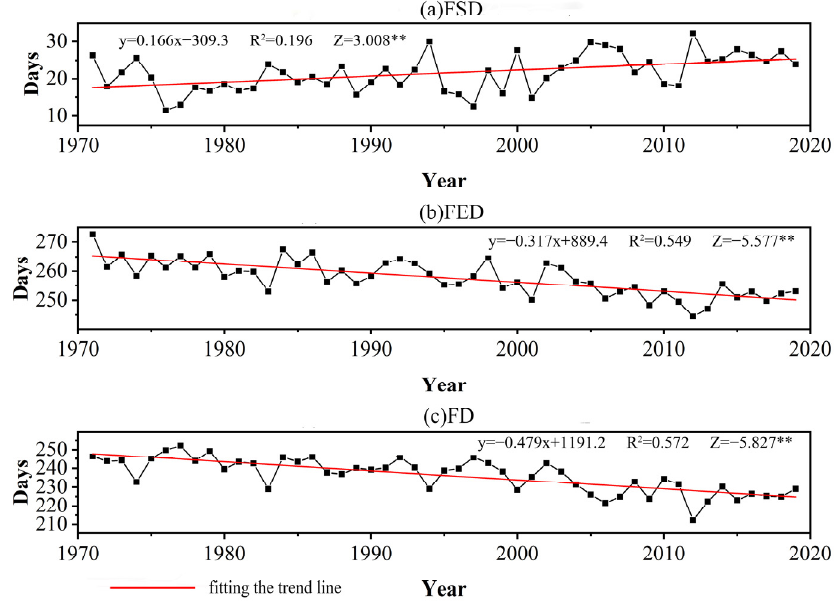
Figure 3. Interannual variation in FSD ( a ), FED ( b ) and FD ( c ) of the soil freeze–thaw processes in Heilongjiang Province (** indicates reaching the significance level of α = 0.01).